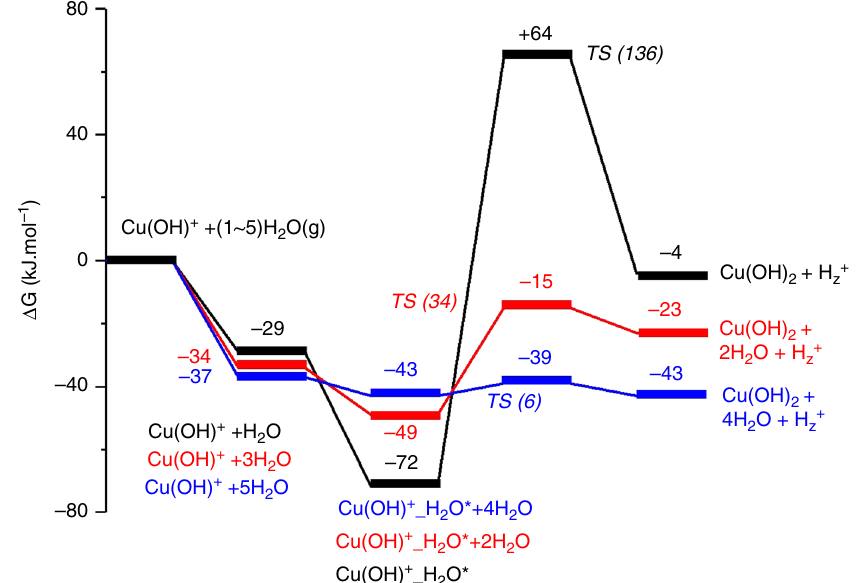
Fig. 5 The effects of water concentration on the hydrolysis of the [Cu II (OH)] + to Cu(OH) 2 . Optimized structures of each intermediates are given in Supplementary Fig.